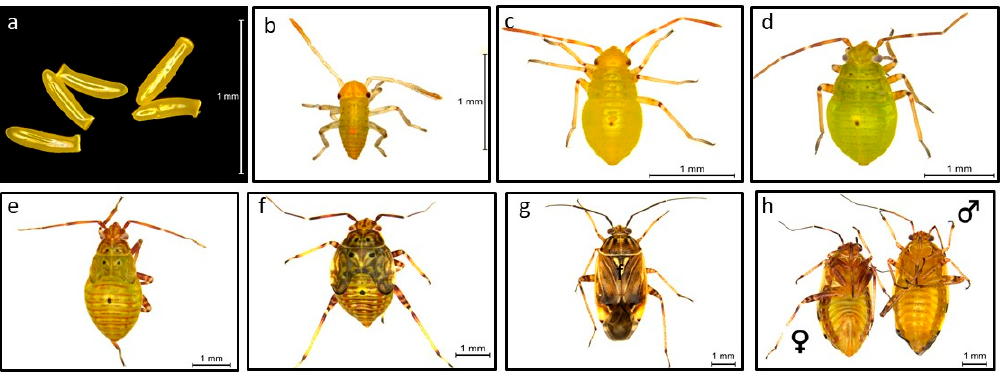
Figure 1. Lygus lineolaris (Hemiptera: Miridae) lifecycle stages. ( a ) Eggs; ( b ) 1st instar nymph; ( c ) 2nd instar nymph; ( d ) 3rd instar nymph; ( e ) 4th instar nymph; ( f ) 5th instar nymph; ( g ) adult; ( h ) ventral side of adult female with ovipositor ( left ) and adult male ( right ).